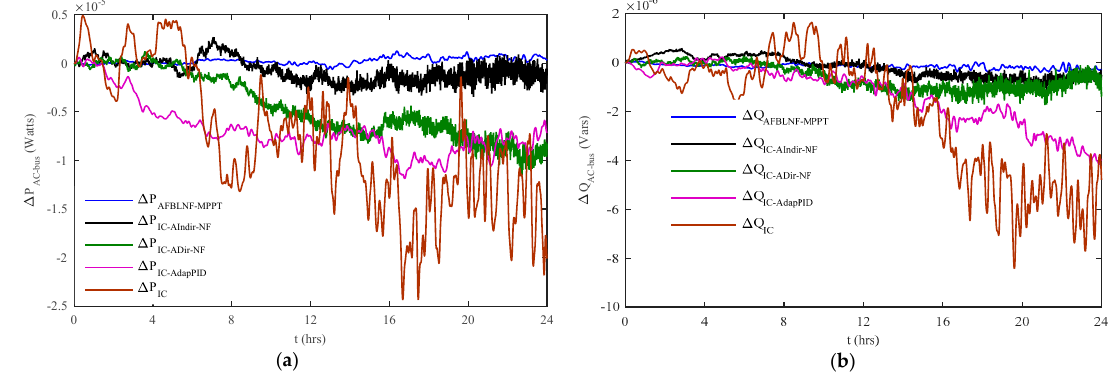
Figure 8. AC bus ( a ) Active power ( b ) Reactive power deviations.